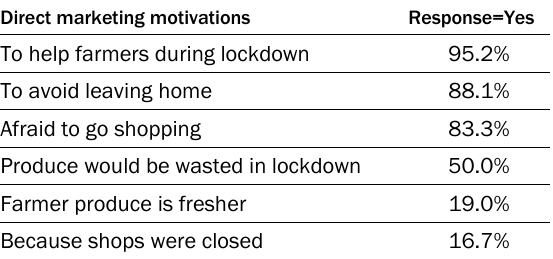
Table 4. Resident Welfare Association (RWA) Motivations for Engaging with Farmers for